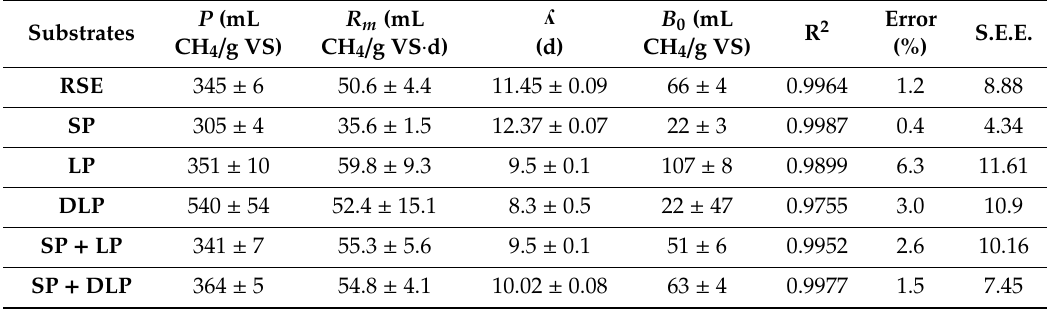
Table 3. Values of the parameters obtained from the logistic model (sigmoidal 4 parameters) for the different substrates and mixtures studied (hydrothermal treatment at 170 °C).